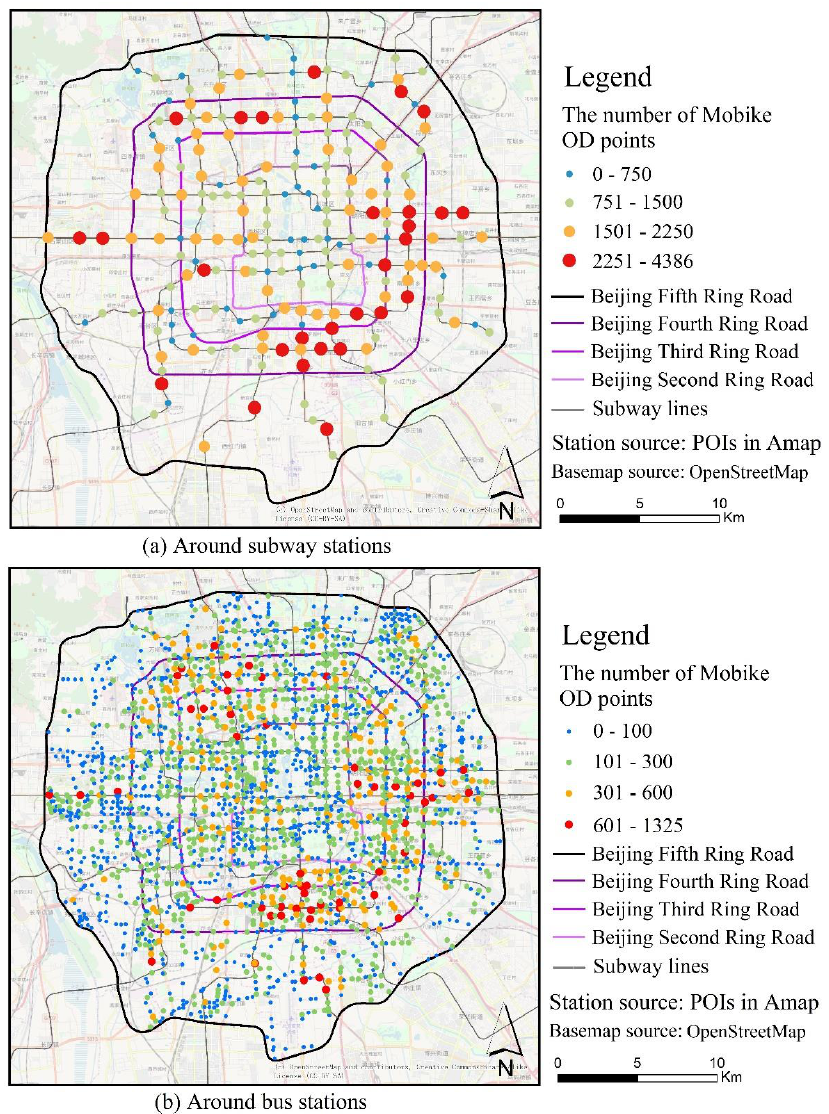
Figure 8. Spatial distribution of the number of OD points around the subway and bus stations.